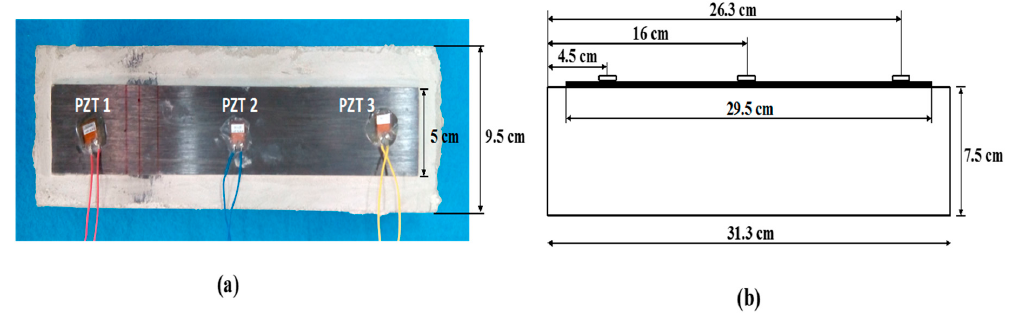
Figure 10. FRP-strengthened concrete specimen with three PZT transducers.